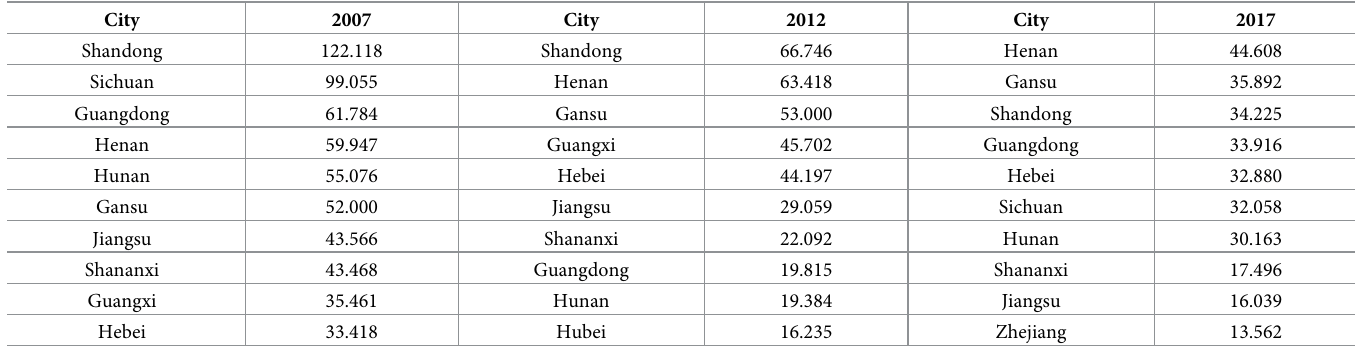
Table 3. Intermediate centrality.